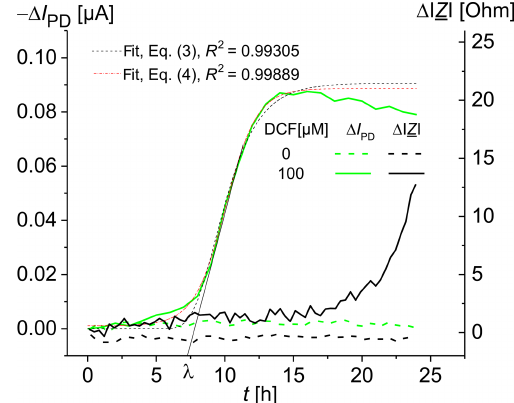
Figure 3. Time-dependent change in the photodiode current I PD and the impedance modulus | Z | at 100kHz for living S. cerevisiae BY4741 p426PDR5-tGFP cells, immobilized in 0.75% agarose gel in the lower microfluidic chambers (7 × 10 6 cellsmL − 1 ). The up- per microfluidic chambers were overflowed with MM, containing 0µMDCF (in the reference channel) and 100µMDCF (in the mea- suring channel), respectively, at a rate of 20µLmin − 1